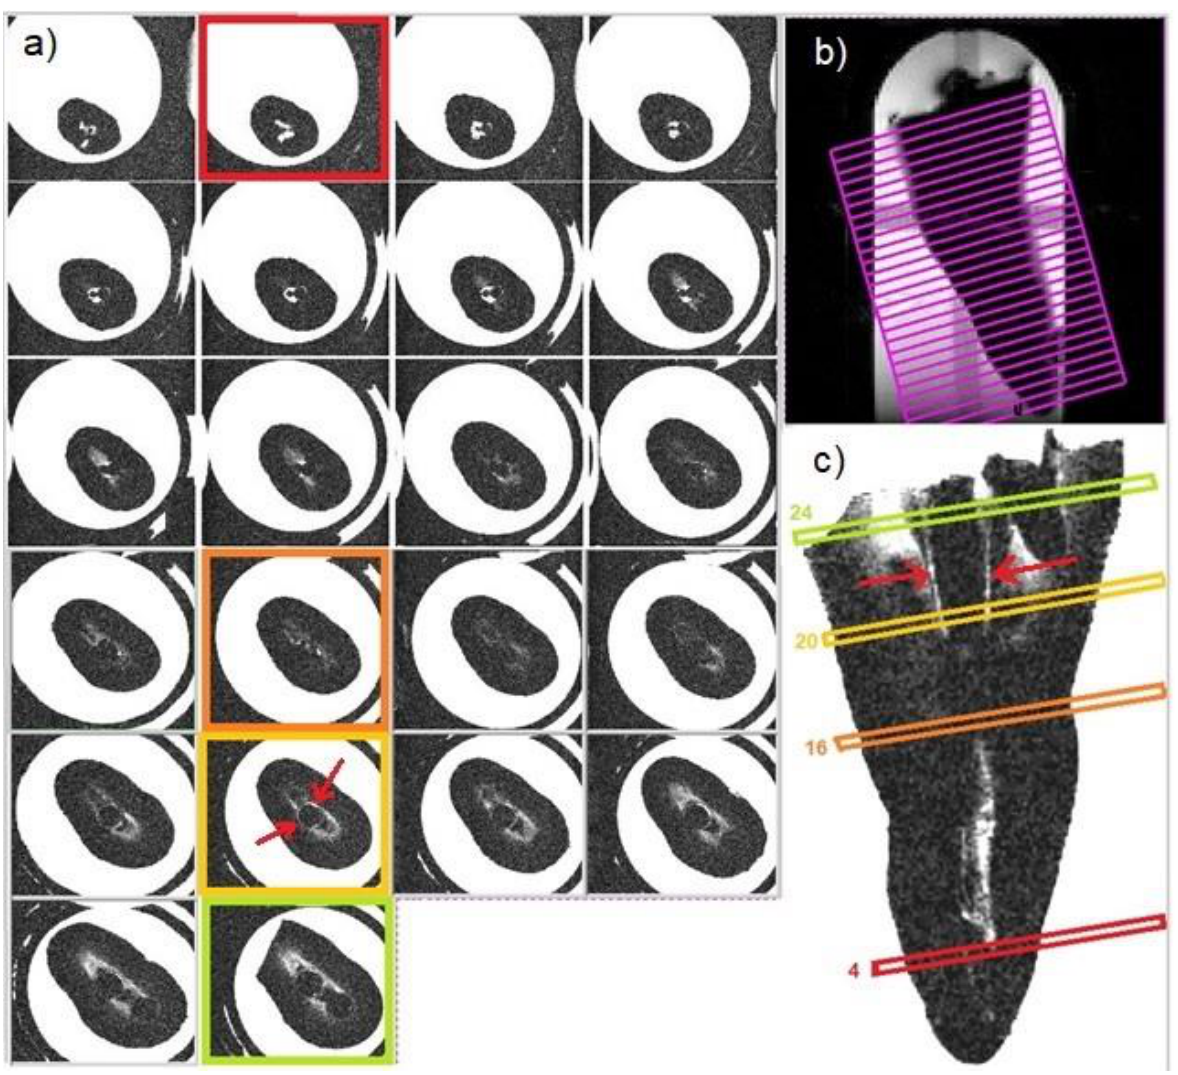
Figure 3. Axial view obtained by mMRI ( a ): slices correspond to the violet slices of the caption ( b ). In the transversal view ( c ), slices are highlighted with different colors, corresponding to the colored squares in caption ( a ). Red arrows in the transversal tooth view and axial yellow marked slice indicate spaces filled with water between dentine and Gutta-percha, confirming the presence of a void.